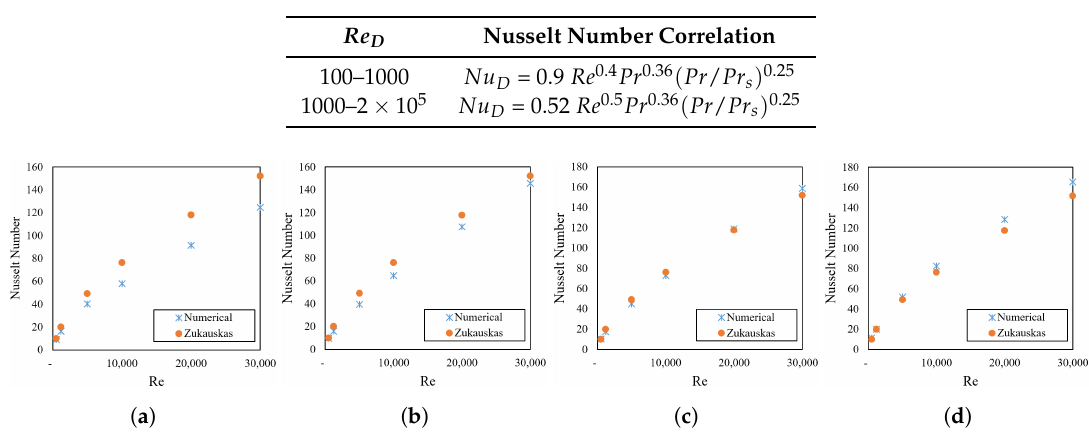
Table 2. Zukauskas Nusselt number correlations.